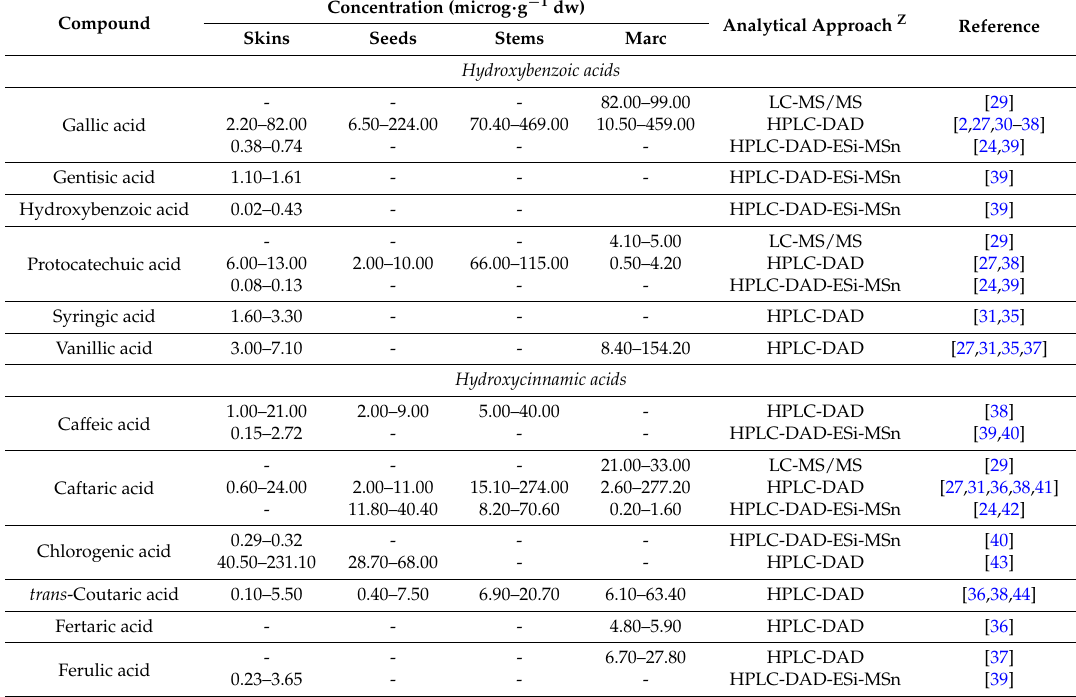
Table 1. Phenolic acids present in winery